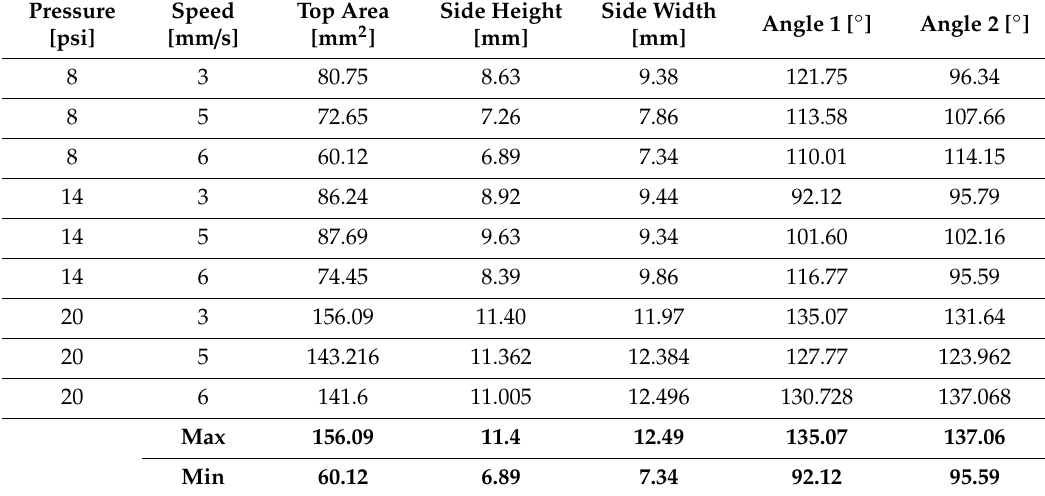
Table 2. Results of the L9 orthogonal array tests and measurements.